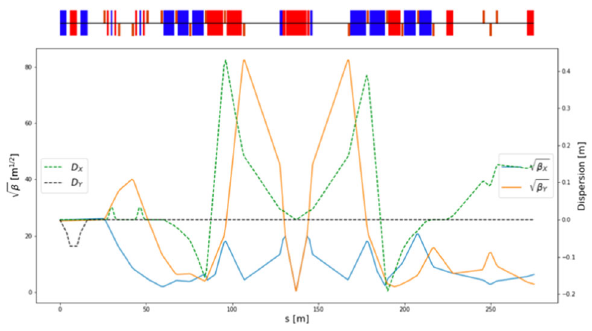
Fig. 15 Optical functions of the electron beam in the IR